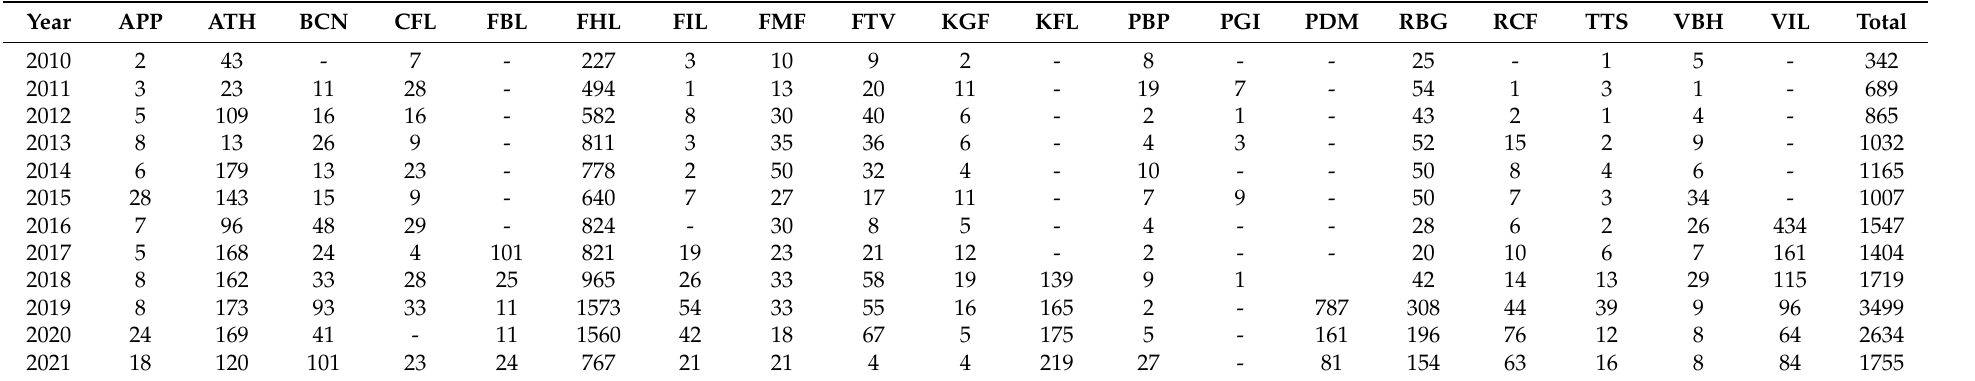
Table 8. Total Number of Trades Per